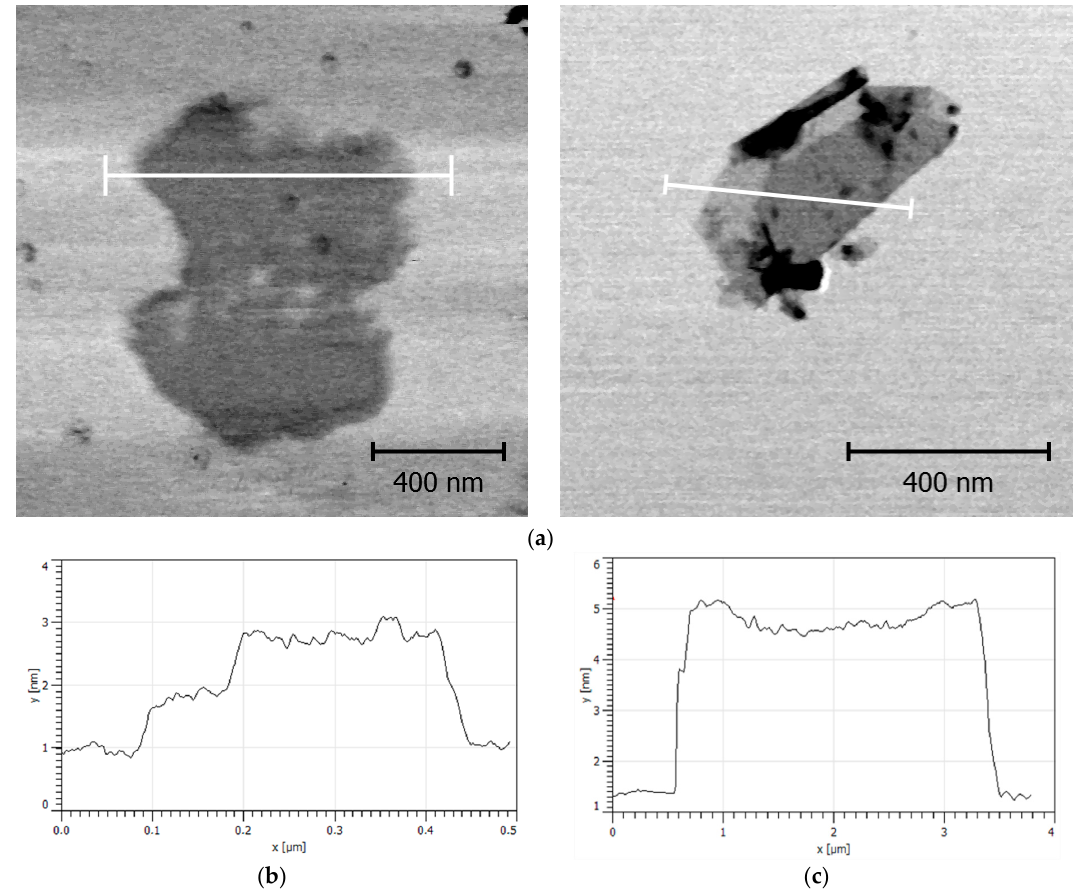
Figure 3. AFM images ( a ) and corresponding thickness profiles for neat GO ( b ) and GO-PBMA ( c